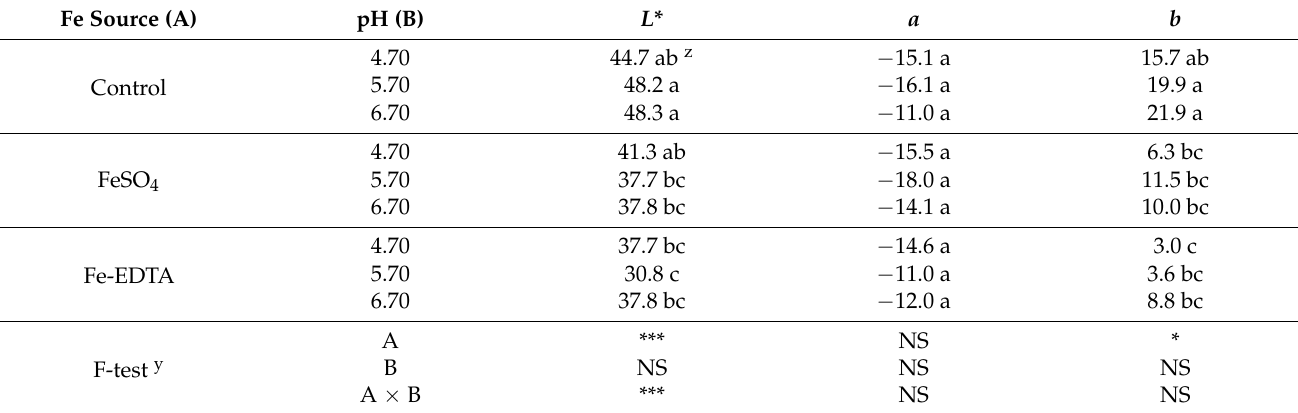
Table 4. The colors of H. macrophylla leaves after 60 days of